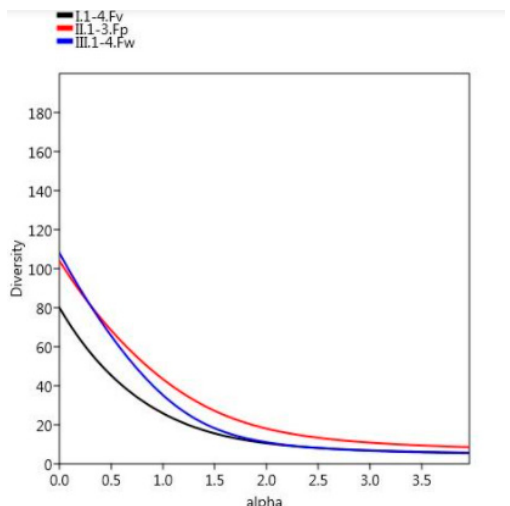
Figure 3. Rényi diversity of the grasslands ( Festuca vaginata vegetation types: I.1-4.Fv, Festuca pseudovaginata II.1-3.Fp and Festuca wagneri III.1-4.Fw).